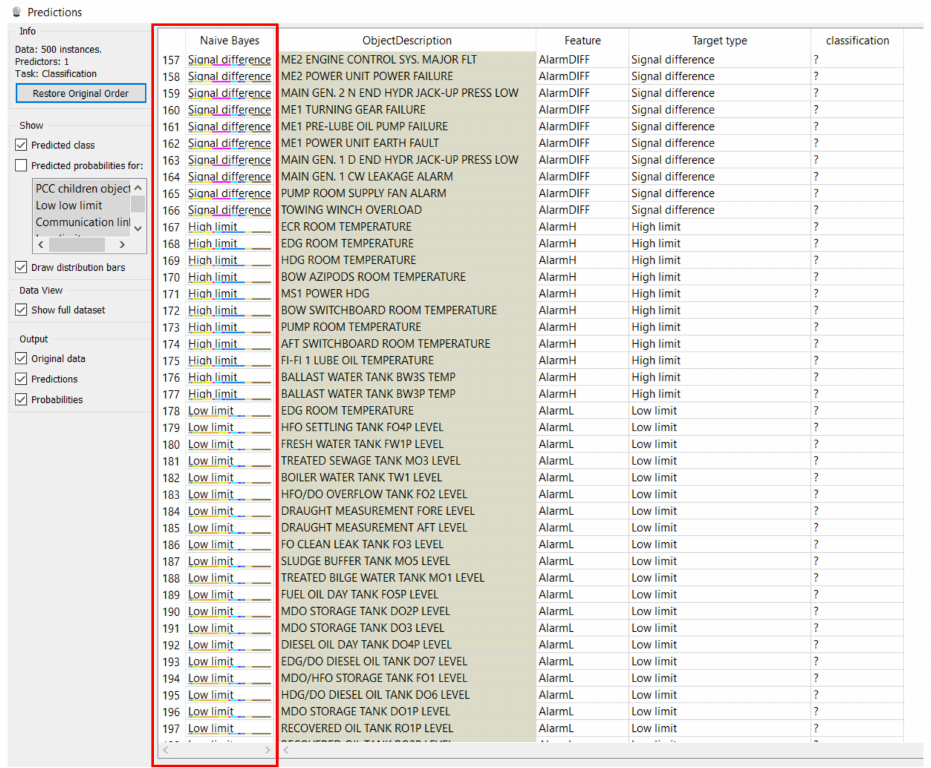
Figure 18. Result of target types for operation